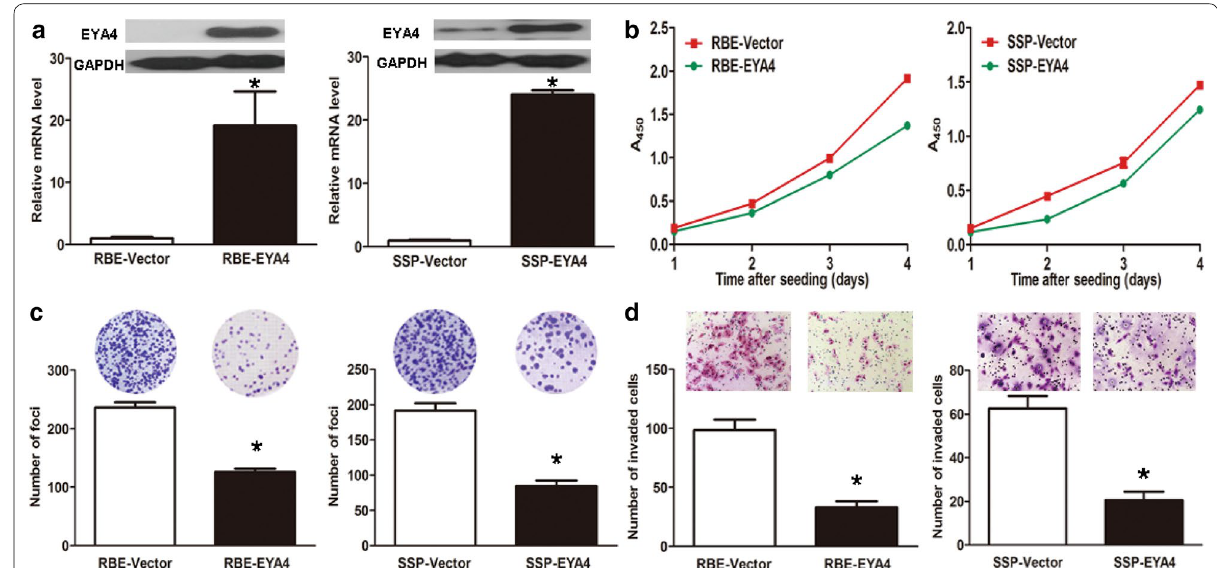
Fig. 3 Tumor‑suppressive effects of EYA4 gene expression in vitro. a EYA4 ‑overexpressing transfectants RBE‑EYA4 and SSP‑EYA4 show significantly elevated expression levels of EYA4 mRNA (* P 0.001 and * P < 0.001, respectively) as well as protein levels. b Overexpression of the EYA4 gene sig‑ = nificantly suppressed the growth rate of RBE‑EYA4 and SSP‑EYA4 compared with RBE‑vector and SSP‑vector, respectively (both * P overexpressing transfectants show weaker capacity in foci formation than their vector control transfectants (both * P < 0.001). d EYA4 overexpression resulted in weakened invasiveness of transfectants (both * P <